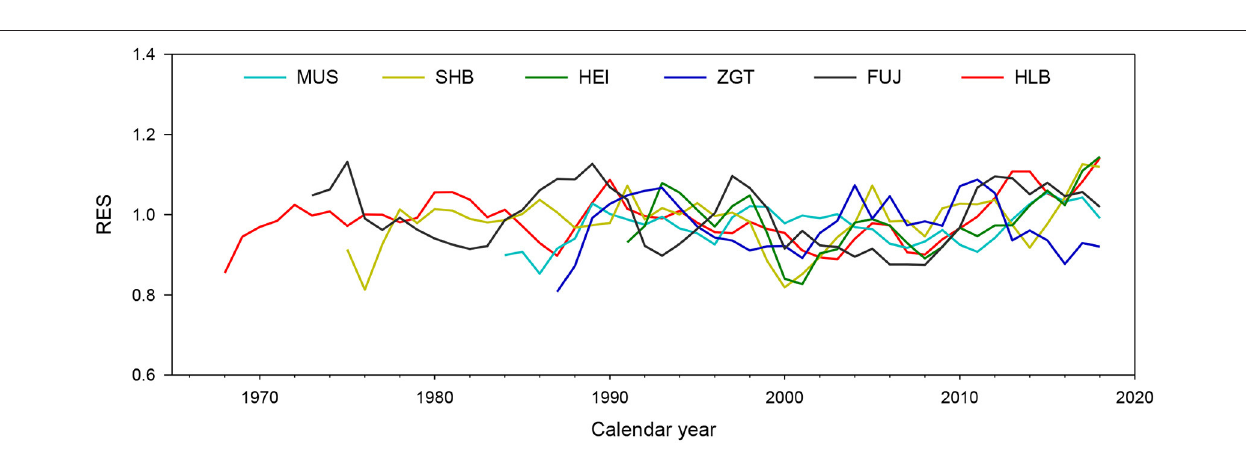
( p < 0.05; Figure 6B ), while the reverse pattern of the impact of competition was